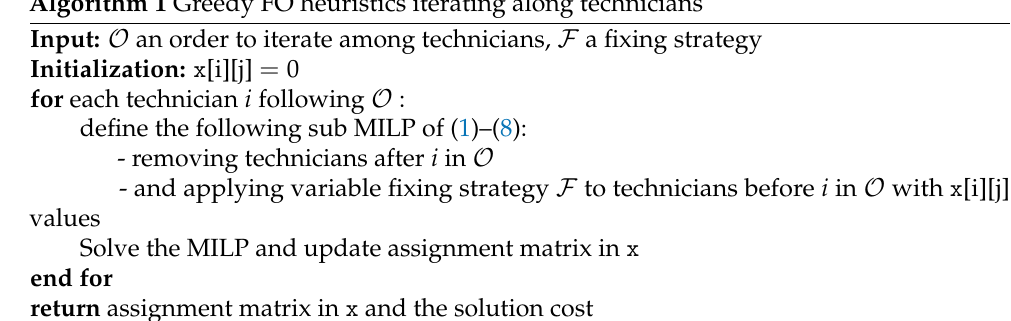
Algorithm 1 Greedy FO heuristics iterating along